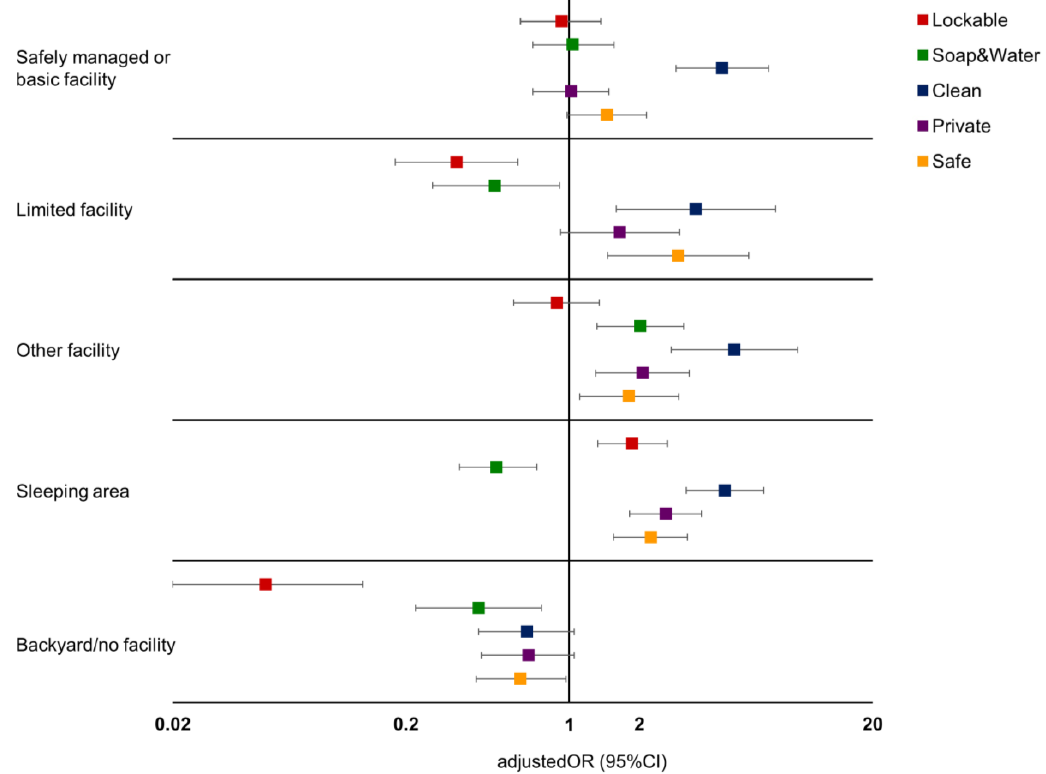
Figure 1. Adjusted odds ratios of the relationship between women’s menstrual management location and their reports of the characteristics of that environment, compared to those using an unimproved sanitation facility (OR = 1.00).